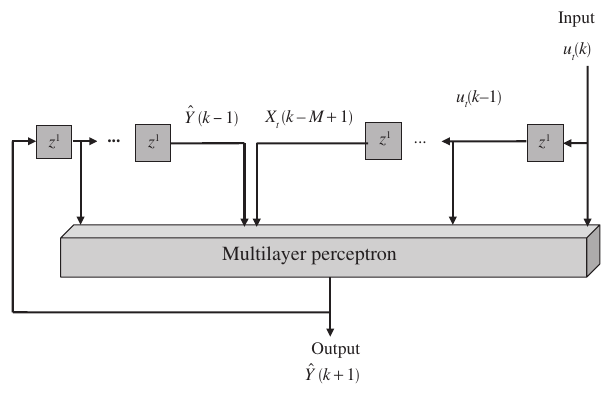
Figure 2: Non-linear ARMAX Model for Modeling the Boiler